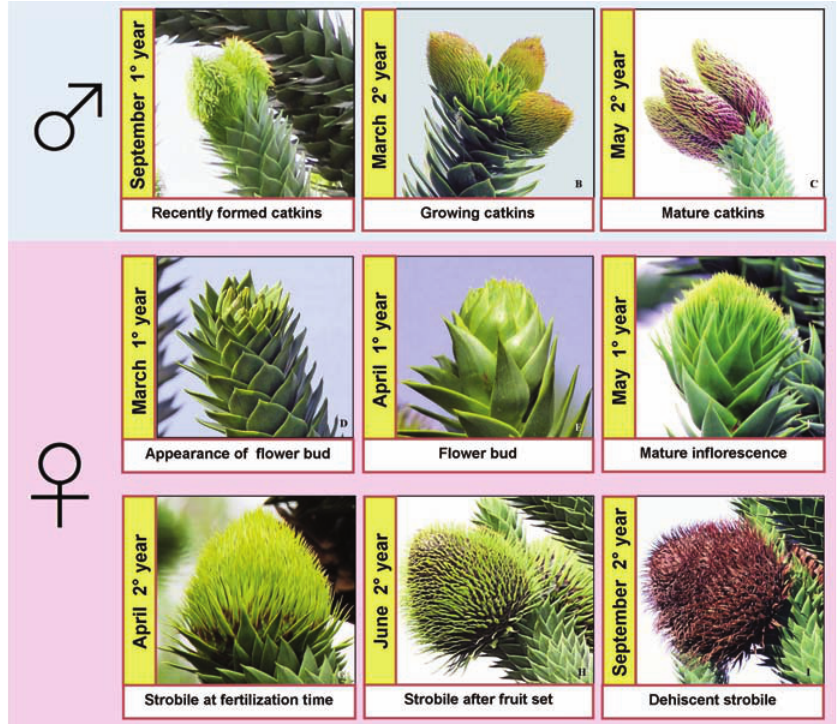
Fig. 1 - Araucaria araucana male ( ♂ ) and female ( ♀ ) phenological stages under Tuscan climate